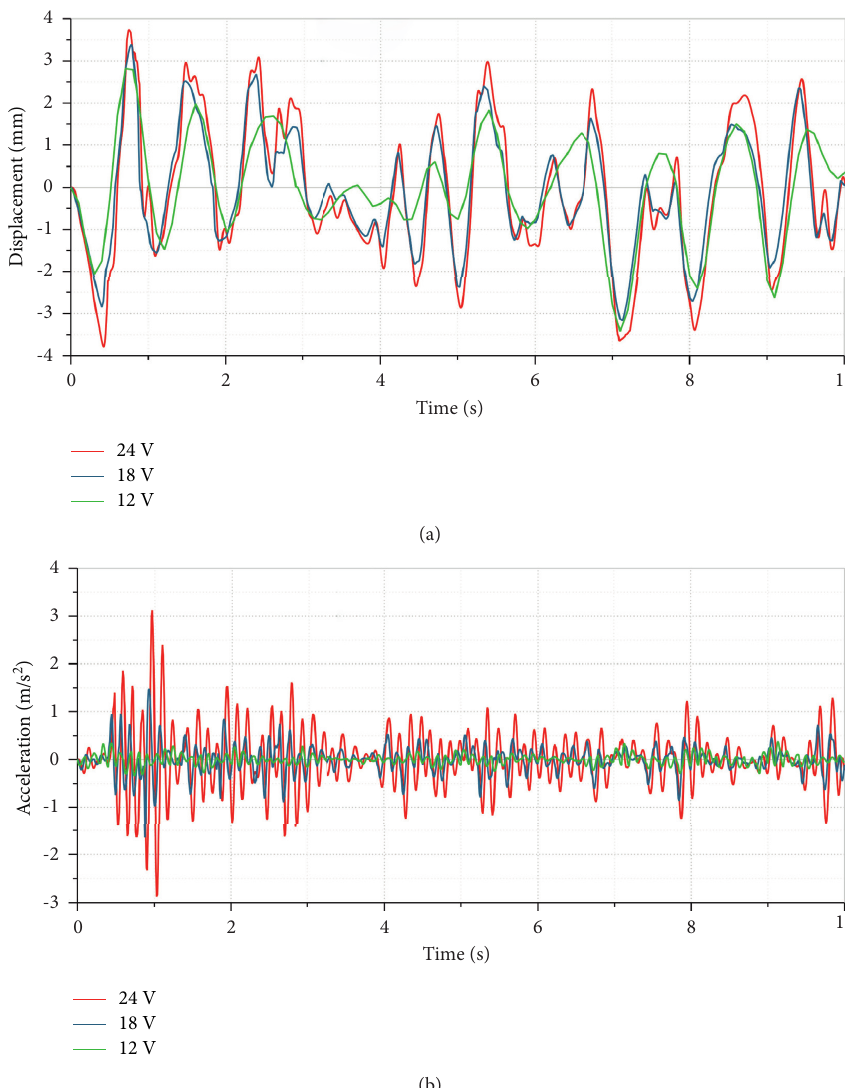
Figure 18: Vibration comparison experiment under different voltage input. (a) Displacement curve. (b) Acceleration